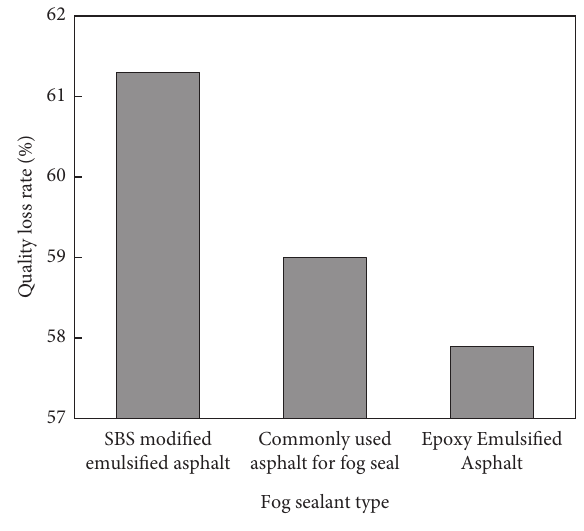
Figure 25: The mass loss